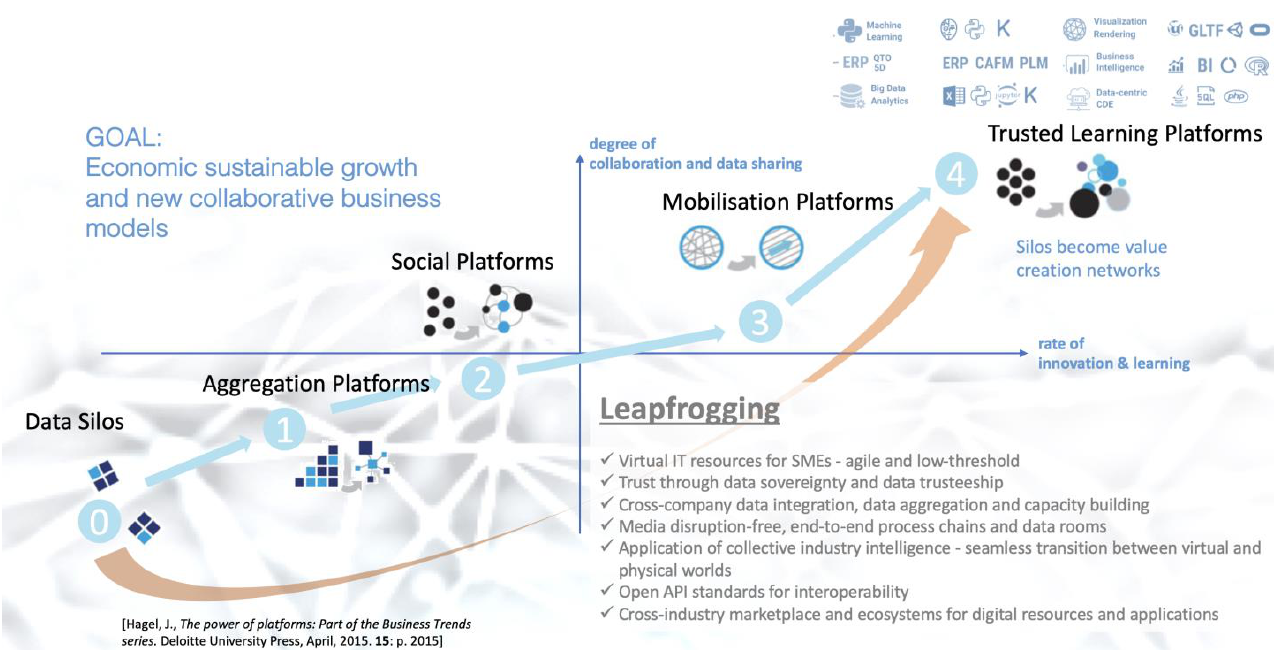
Figure 1. The vision of a data cooperative in construction: From data silo to trusted learning platform. Evolution of platforms; adopted from [7] (reprinted with permission) and based on authors’ own research and depiction.